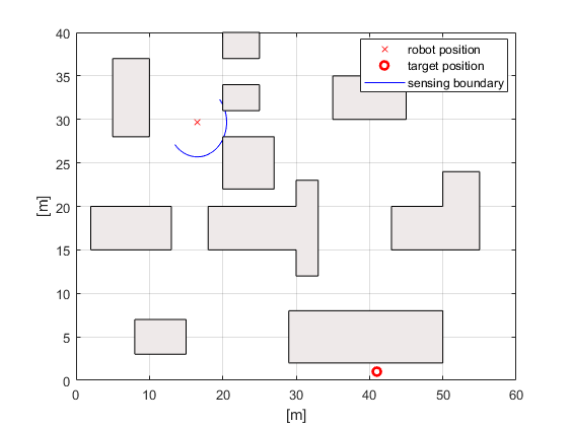
Figure 7. Three gap encountering situation for a mobile robot.